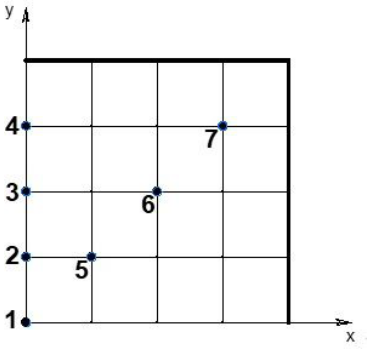
Figure 5: Calculated cross section of the shell when calculating the long-term